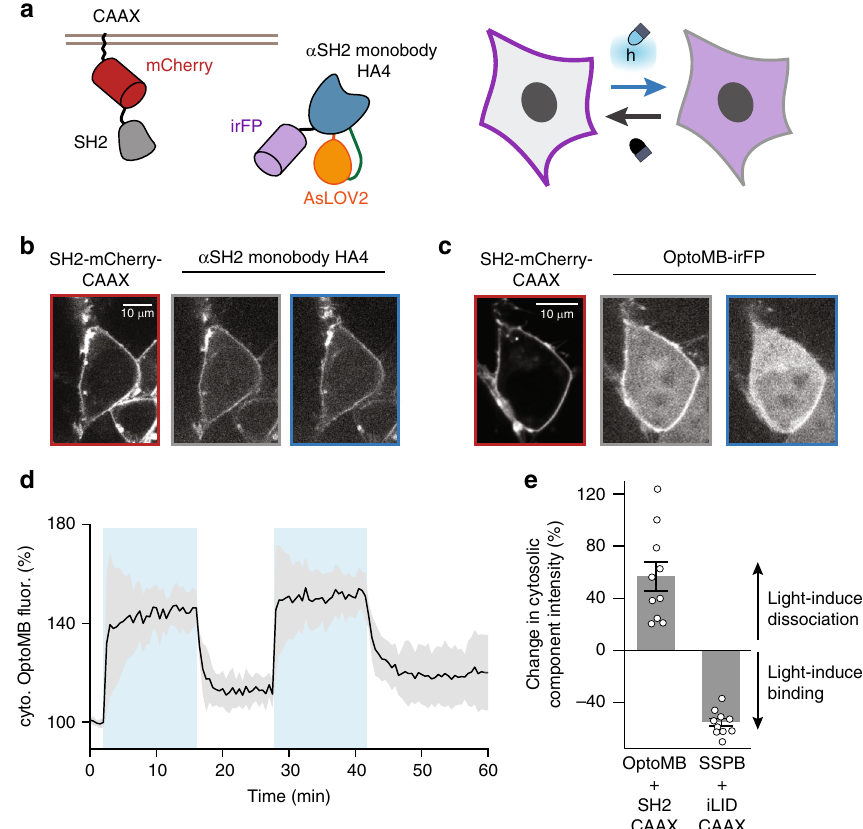
Fig. 5 Characterization of OptoMB in mammalian cells. a Schematic diagram of the membrane-binding assay used, where irFP-tagged OptoMB (blue – orange – purple) binds to a fusion of SH2 (gray), mCherry (red), and CAAX (black), anchored to the plasma membrane (PM) of HEK293T cells. In the dark, OptoMB-irFP binds to the membrane-bound SH2, enhancing irFP signal at the PM and reducing it in the cytosol. In blue light, OptoMB releases SH2, causing a reduction in irFP signal at the membrane and an increase in the cytosol. b , c Images represent two replicate experiments. HEK293T cells expressing SH2-mCherry-CAAX and irFP-tagged HA4 monobody ( b ) or OptoMB-iRFP ( c ) imaged in the dark or blue light. Left panels (red) show mCherry fl uorescence of SH2 fusion anchored to the PM; central (gray) and right (blue) panels show HA4-irFP ( b ) or OptoMB-iRFP ( c ) fl uorescence in the dark and after 30 s of blue light stimulation, respectively, showing irFP-HA4 localized to the PM in either light condition ( b ) or OptoMB enriched at the PM in the dark and in the cytosol in the light ( c ). White scale bar in the cell images is 10 μ m. d Cytosolic OptoMB-iRFP fl uorescence changing over time due to periodic pulses of blue light (blue sections). The fl uorescence is expressed in percentage from the original value of cells in the dark. Curve and shaded regions indicate mean ± SD for at least 10 cells respectively. e Comparison of light-induced translocation by OptoMB and iLID-SSPB. Error bars indicate mean ± SEM for n = 10 cells per variant. For iLID/SSPB translocation, cytosolic BFP fl uorescence was measured using NIH3T3 cells with a stably integrated BFP-SSPB-SOScat-P2A-iLID-CAAX lentiviral construct. Source data are provided as a Source Data fi